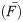
Land use effects on natural resource diversity.Effect of land use type (secondary forest (N = 8), agroforest (N = 17) and pasture (N = 7)) on total natural resource diversity (FT) (a), average natural resource diversity (F)¯ (b), and Simpson’s Index of Natural Resource Diversity (D) (c). Non-overlapping letters signify significant difference at α ≤ 0.05.